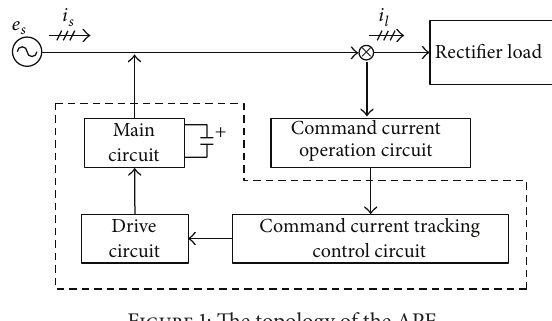
Figure 1: The topology of the APF.